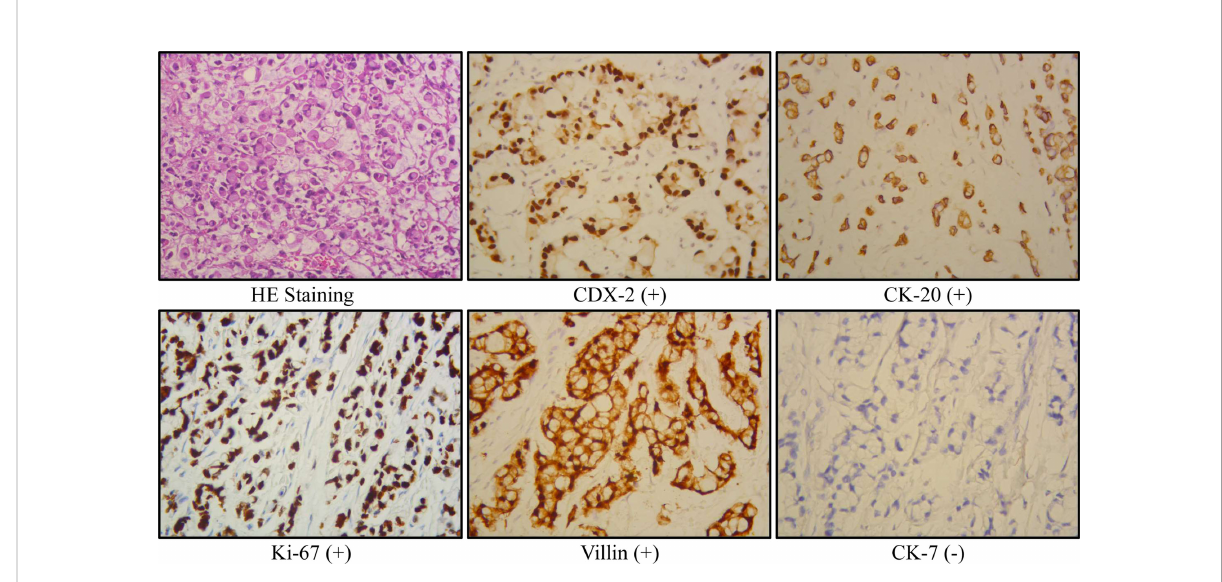
FIGURE 2 Representative immunohistochemical results of the current urachal signet ring cell carcinoma